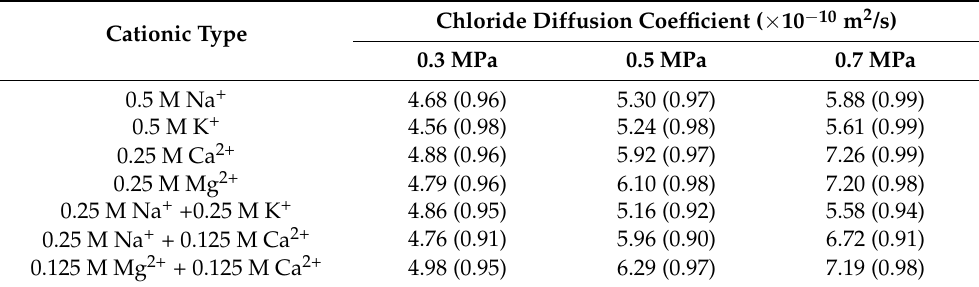
Table 5. Chloride diffusion coefficient in pressurized diffusion source solutions (0.5 M Cl − ).